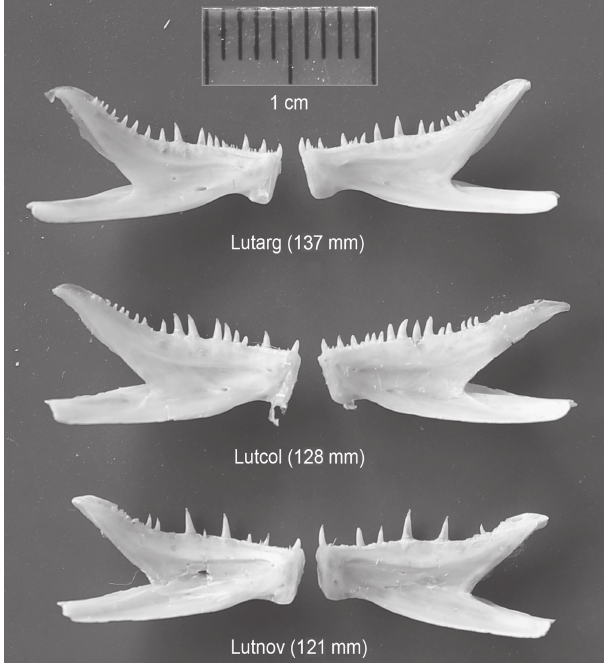
Fig. 2. Dentaries of three species of snappers. In brackets, standard lengths of fish. Lutarg: Lutjanus argentiventris ;